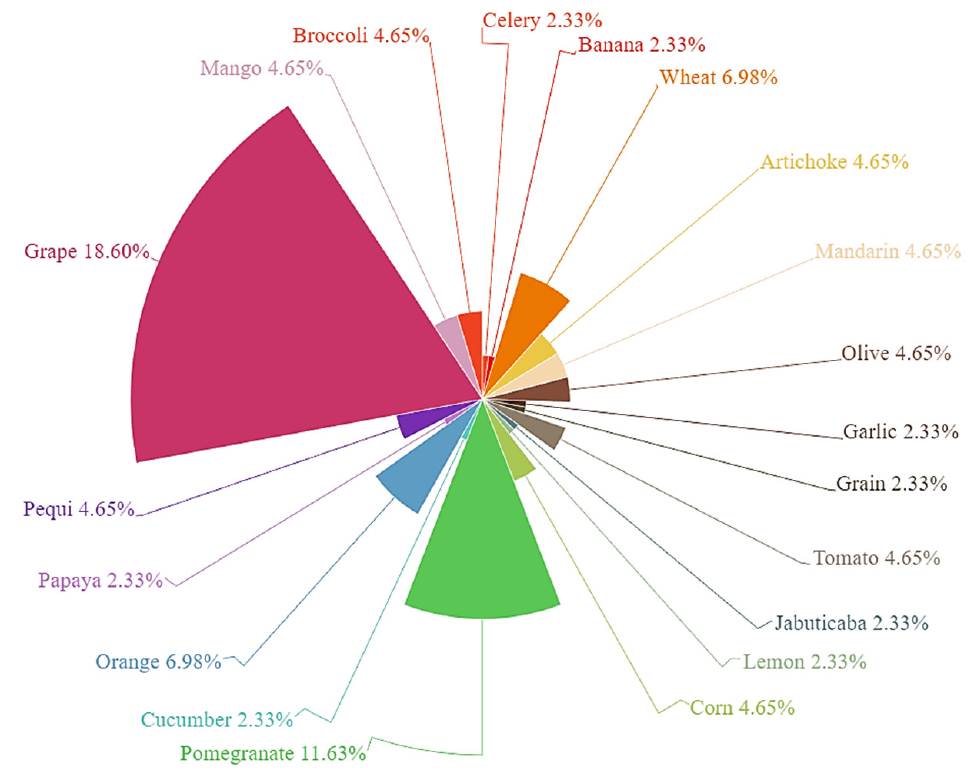
Figure 2. The relative percentage of the studies on the application of by-products in cheesemaking considered in this review.